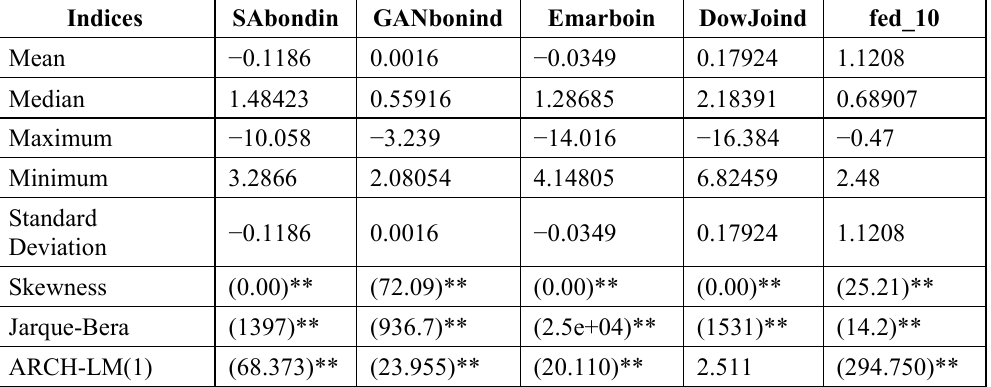
Table 1. Summary of Descriptive